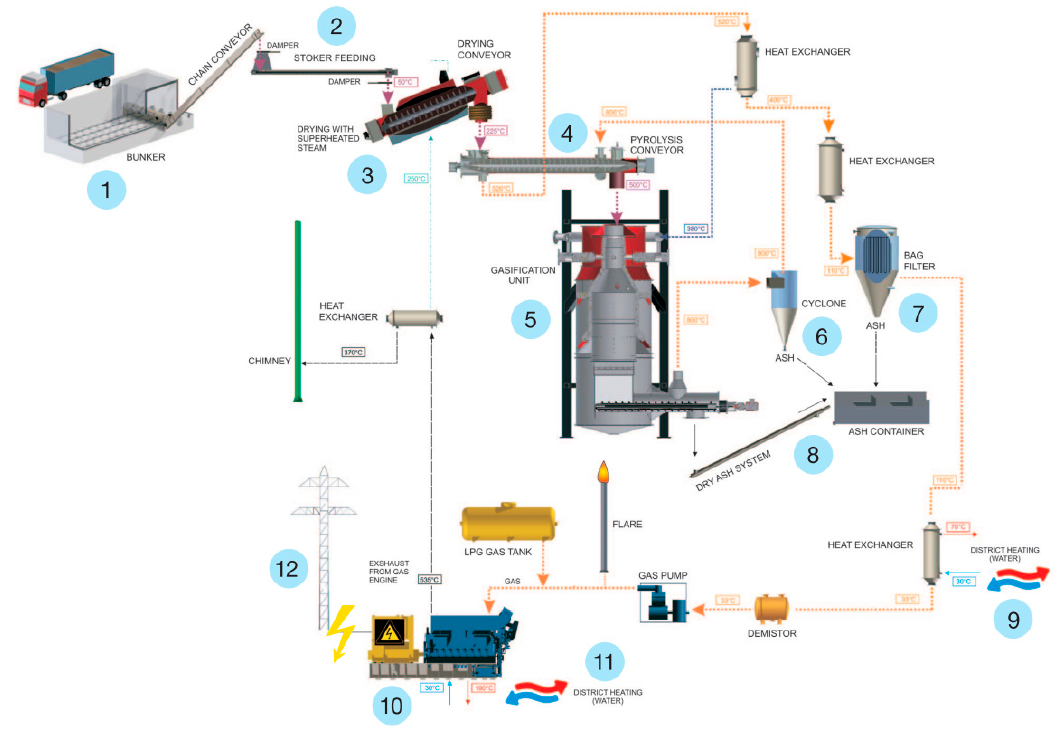
Figure 19. Power Plant layout of the Weiss Tar-Free two-stage gasification system [24].